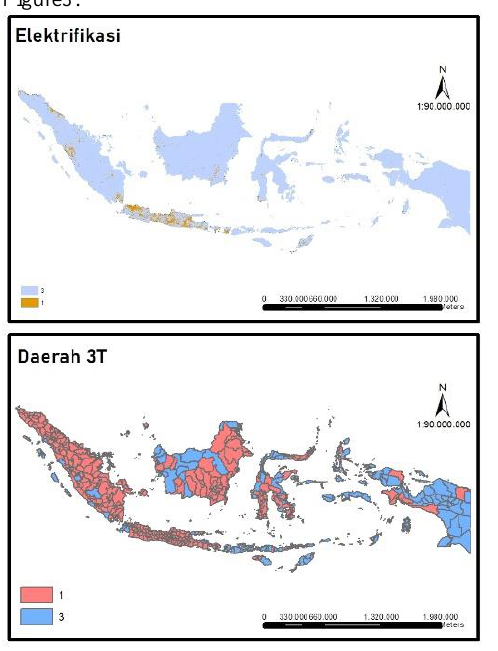
Figure 3 Electrification and Regional 3T Data Scoring